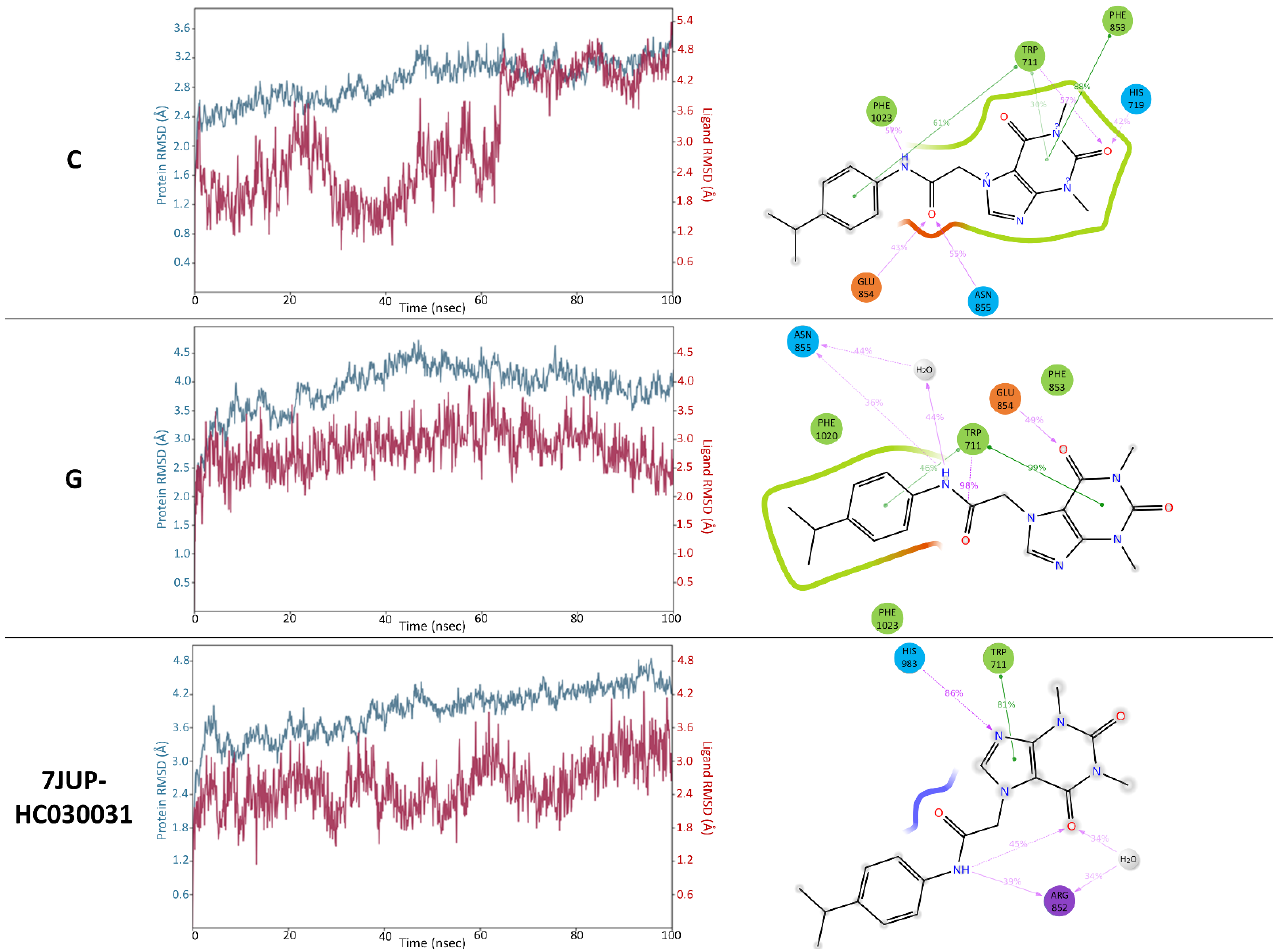
Figure 10. Results of 100 ns MD simulation for C, G, and 7JUP-HC-030031 complexes—RMSD plots (protein—blue, ligand—red), binding interactions formed, and their durability (percentage of the total simulation time).